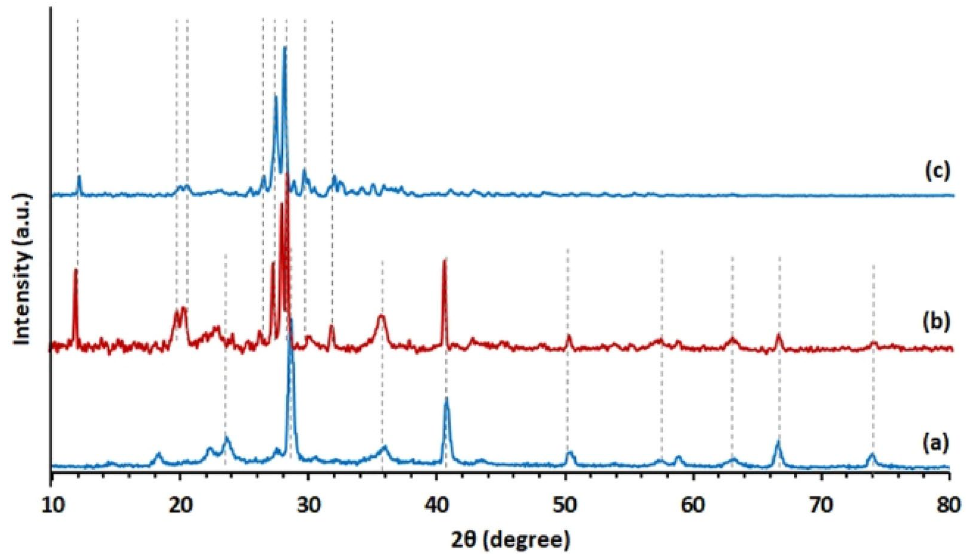
Figure 8. XRD patterns of Fe 3 O 4 @SiO 2 @TAD-G3 ( a ), Fe 3 O 4 @SiO 2 @TAD-G3/Favipiravir ( b ), and Favipiravir ( c